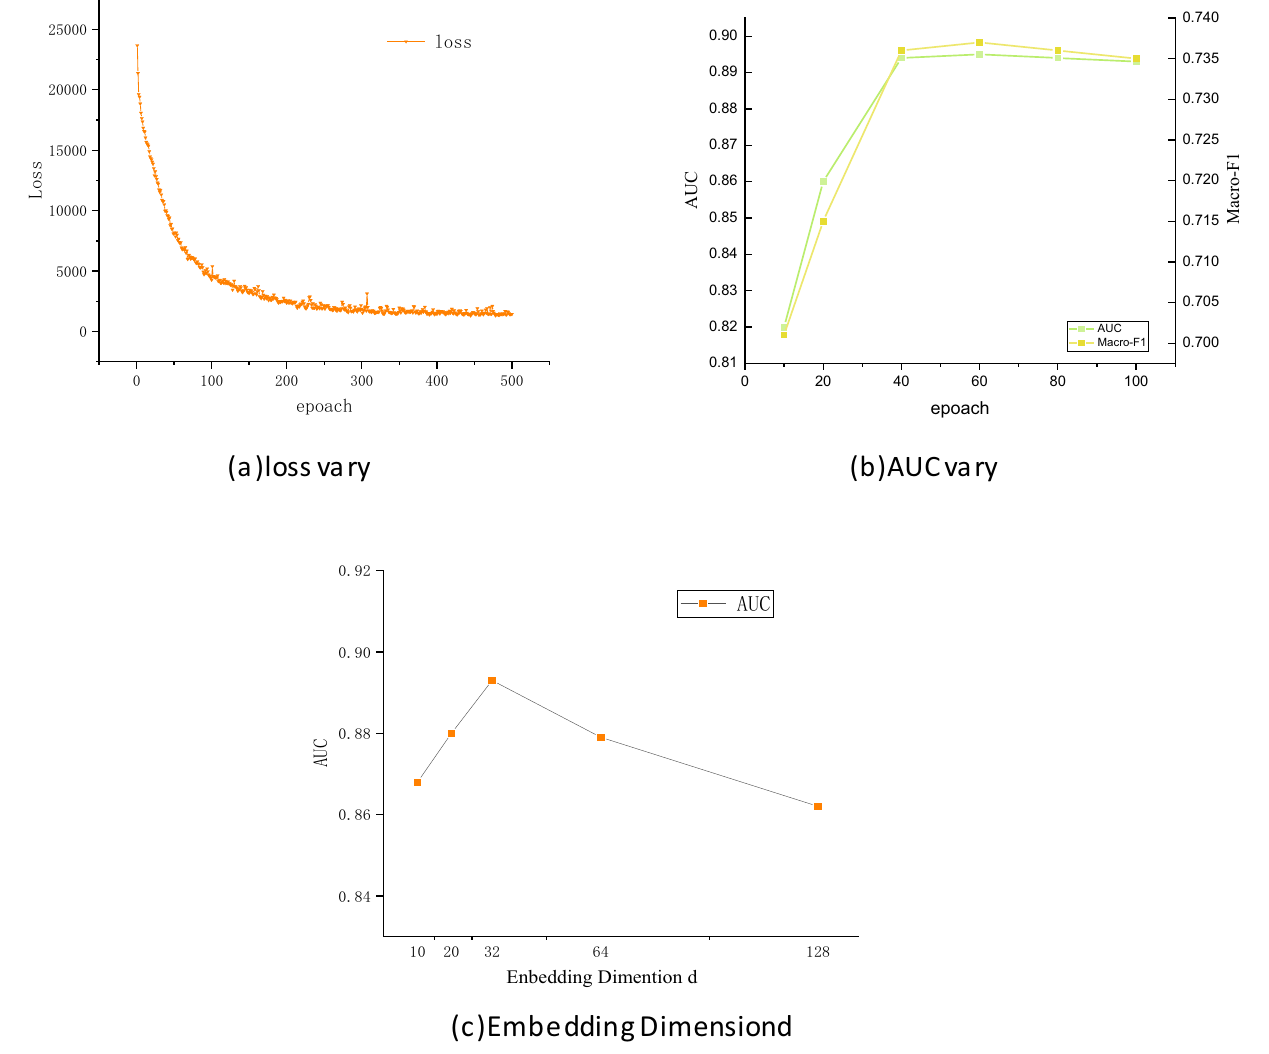
Fig. 5 Parameter analysis for sign